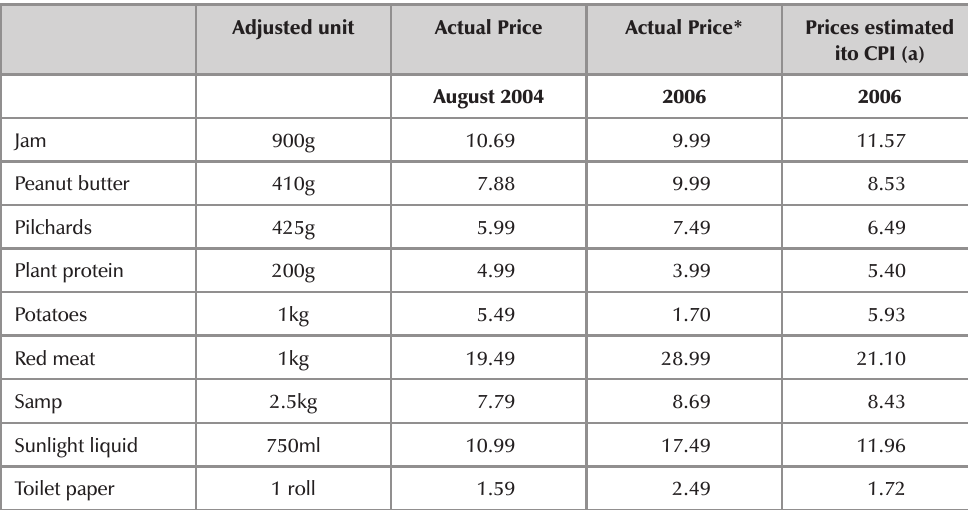
Table 4d Items with prices available from 2004 to